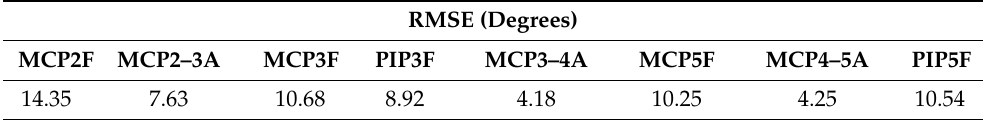
Table 5. Root mean square errors (RMSE) per joint obtained for Experiment B computed from all frames. 1 to 5 refers to thumb to little fingers. F stands for flexion/extension and A for abduc- tion/adduction movements.